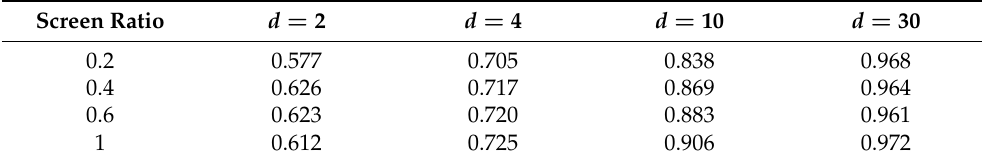
Table A2. Average Pearson Correlation Between Stage 1 and Stage 2 p -values in Simulation. Average Sequencing Depth d = 2,4,10,30.